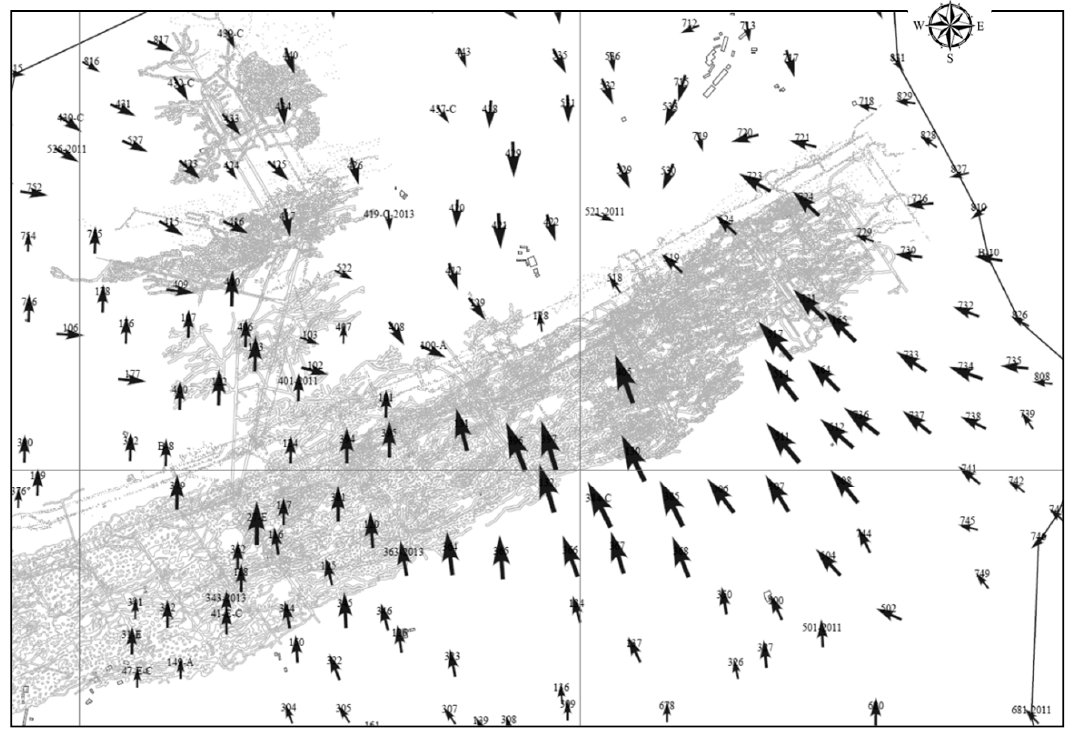
Figure 7. Vectors standing for the horizontal displacements. Scale 1:15,000.